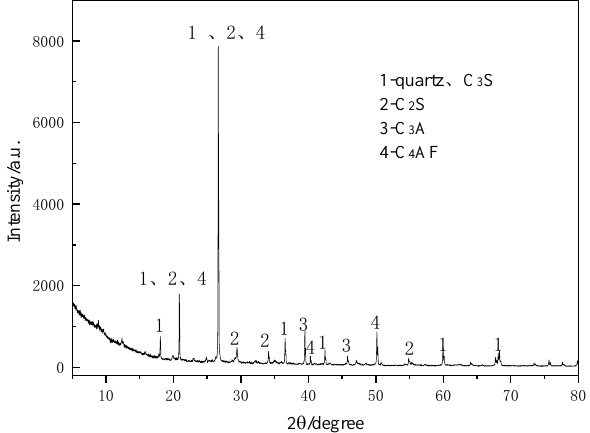
Figure 8. XRD of dry-mixed mortar cured for 7 days after molding.